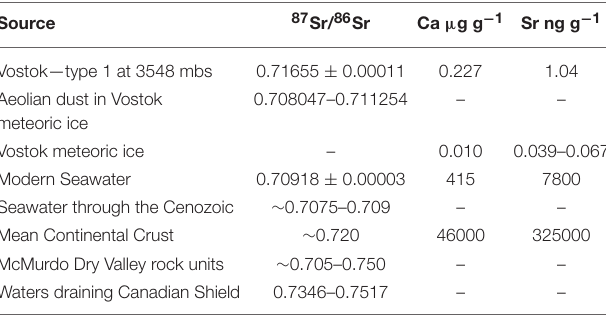
TABLE 1 | Comparison of 87 Sr/ 86 Sr and Sr and Ca concentrations of Lake Vostok Type 1 accretion ice (this work) with selected materials summarized from the text.